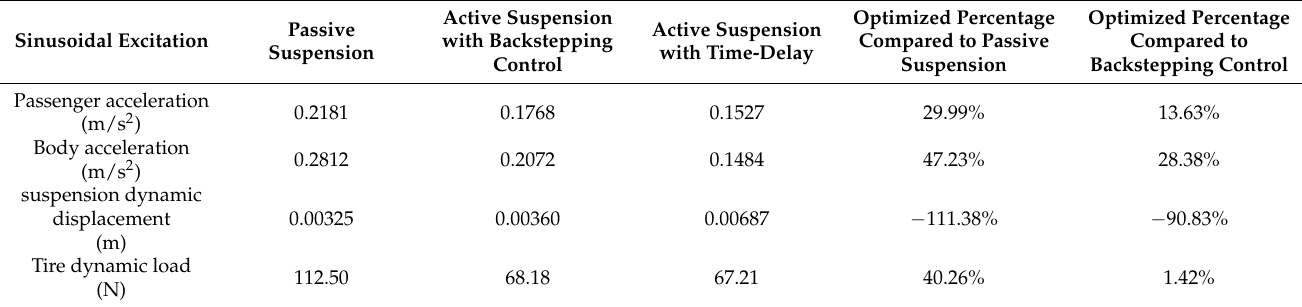
Table 4. Suspension performance root mean square value comparison